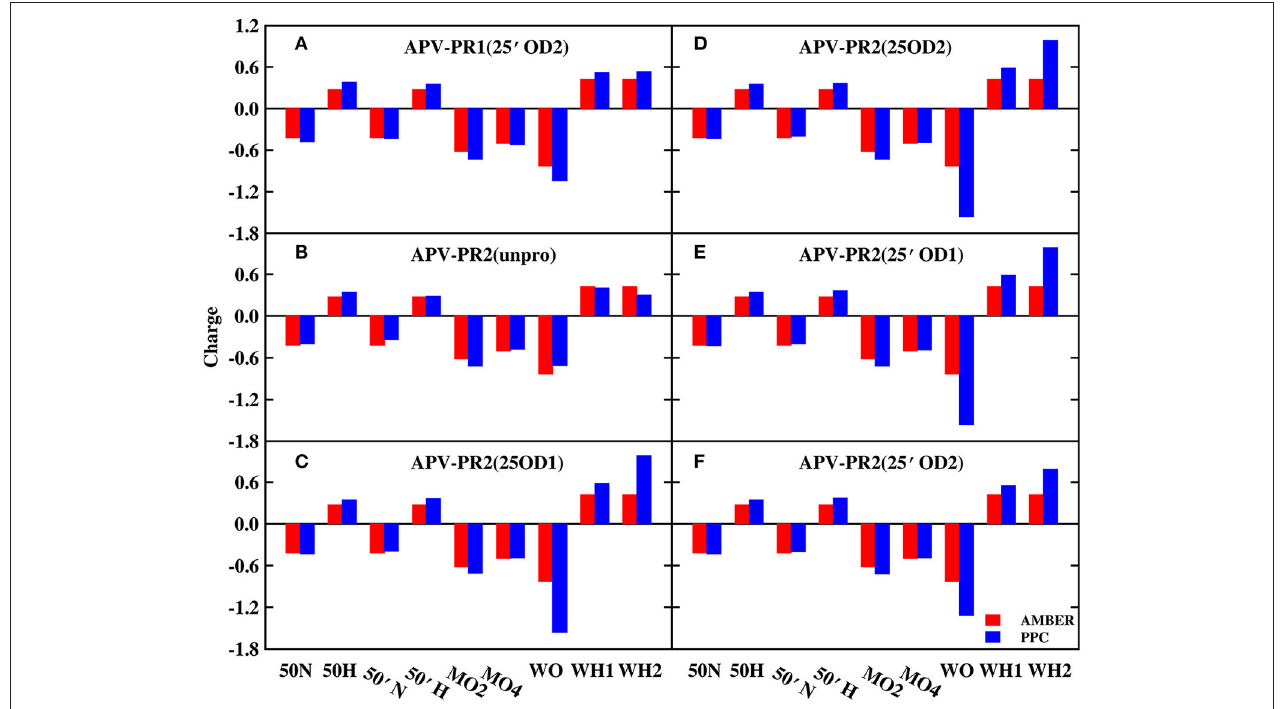
FIGURE 3 | The charge of bridging water molecules and surrounding atoms that form hydrogen bonds in APV complex. (A) APV-PR1(25 ′ OD2) system. (B) APV-PR2(unpro) system. (C) APV-PR2(25OD1) system. (D) APV-PR2(25OD2) system. (E) APV-PR2(25 ′ OD1) system. (F) APV-PR2(25 ′ OD2) system.